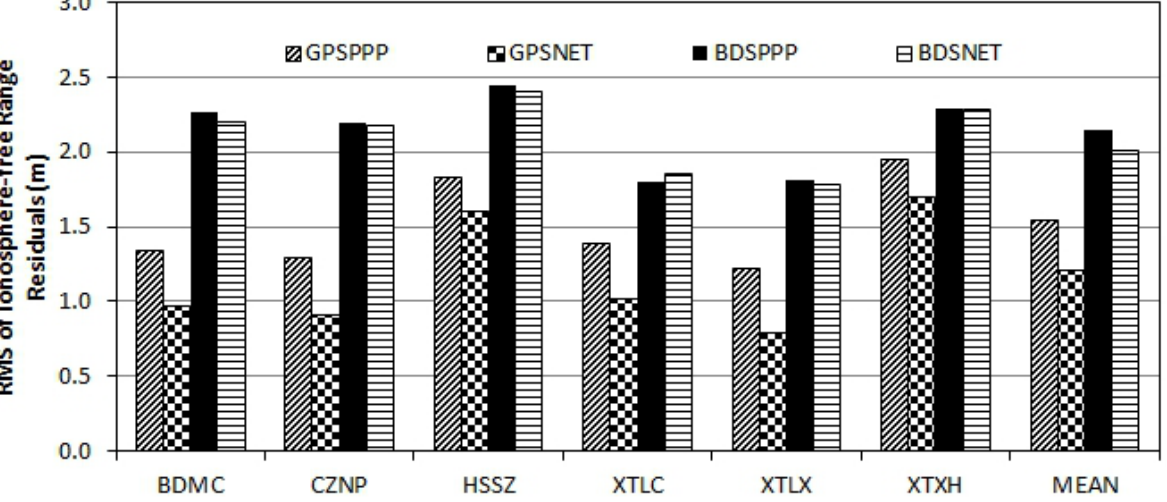
Figure 5. RMS of the ionosphere-free range observations of the four processing scenarios. Both PPP and network solutions have similar range RMS. BDS range RMS is twice as large as that of